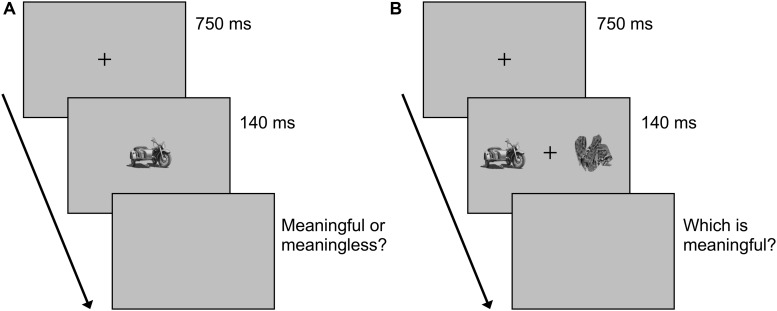
Schematic of the task in (A) Experiment 2A and (B) 2B.